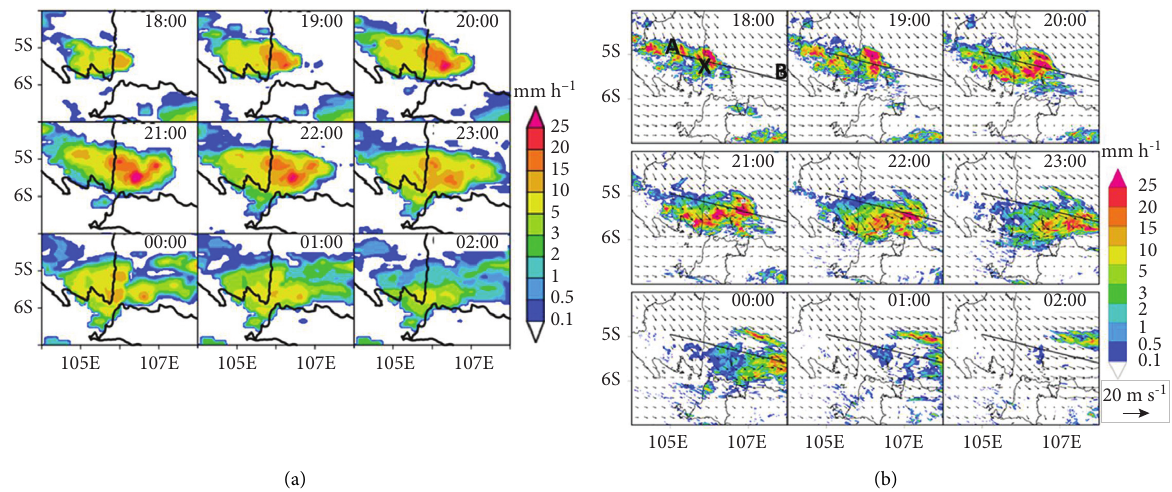
Figure 6: Same as Figure 5, but for (a) observed hourly rainfall from GSMaP satellite data; (b) simulated hourly rainfall and wind vector (925 mb) from domain 3 of WRF model simulation. A-B transect delineated through coastline (X) (105.85 ° E, 5.15 ° S) used for further analysis in Figures 8 and